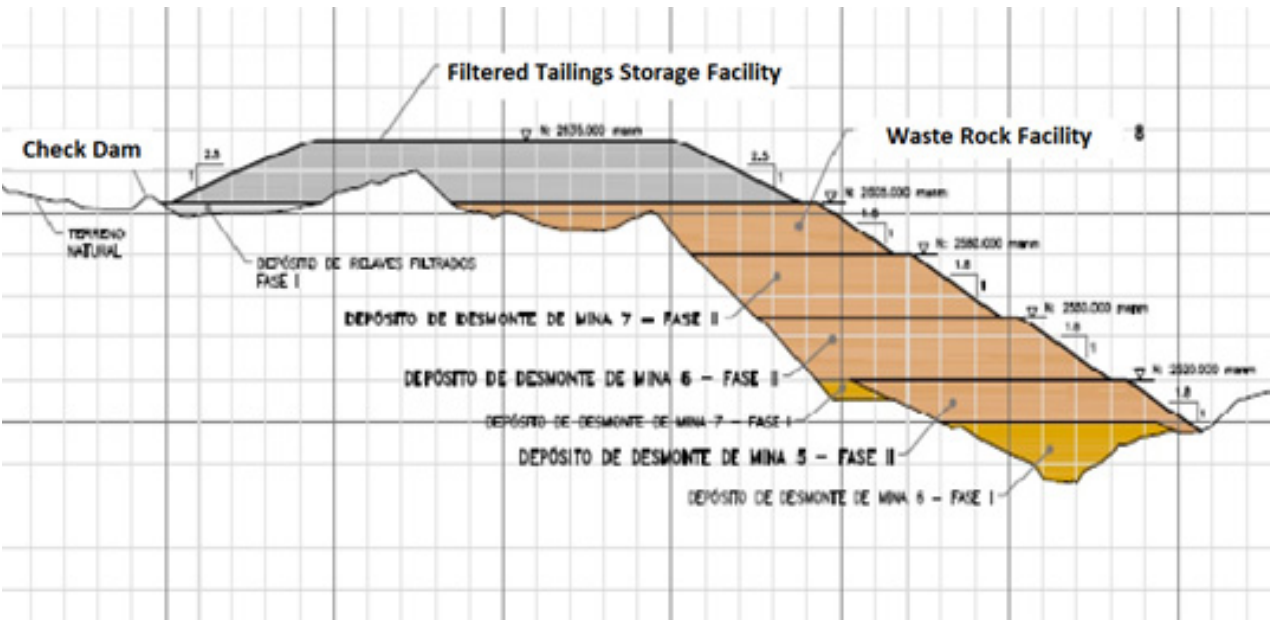
Figure 64. Curaubamba Filtered TSF—Terraces Overall View [38,39].